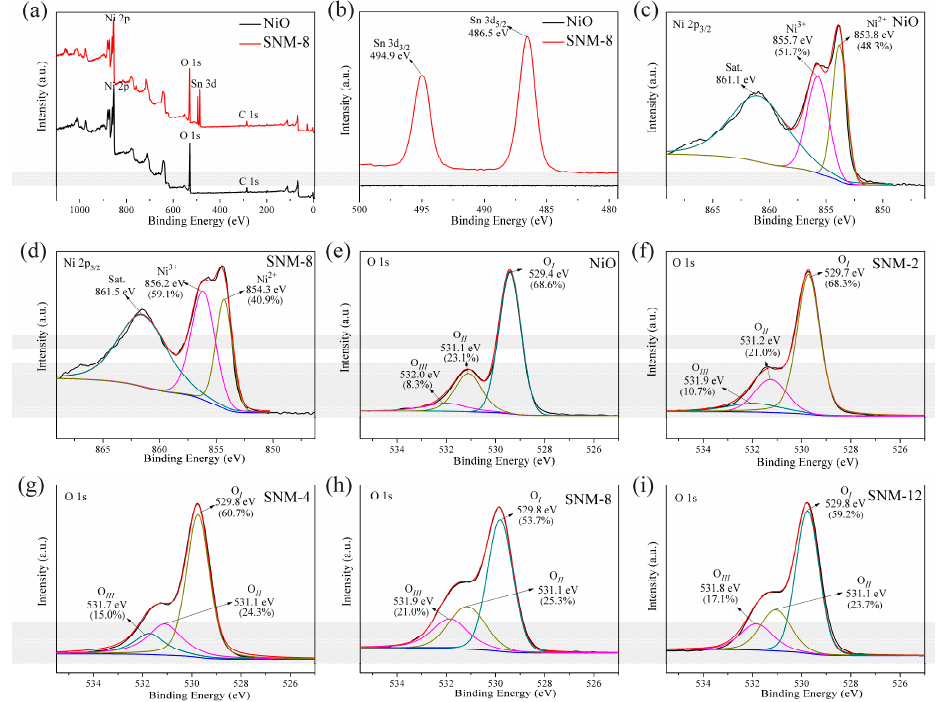
Figure 5. ( a ) Survey XPS patterns of the pure NiO and SNM-8 samples; ( b ) Sn 3d spectrum of the SNM-8 sample; ( c , d ) Ni 2p 3/2 high-resolution XPS spectra of the pure NiO and SNM-8, respectively; sample; ( c , d ) Ni 2p 3 / 2 high-resolution XPS spectra of the pure NiO and SNM-8, respectively; ( e – i ) O 1s high-resolution XPS spectra of the pure NiO, SNM-2, SNM-4, SNM-8, and SNM-12 samples,